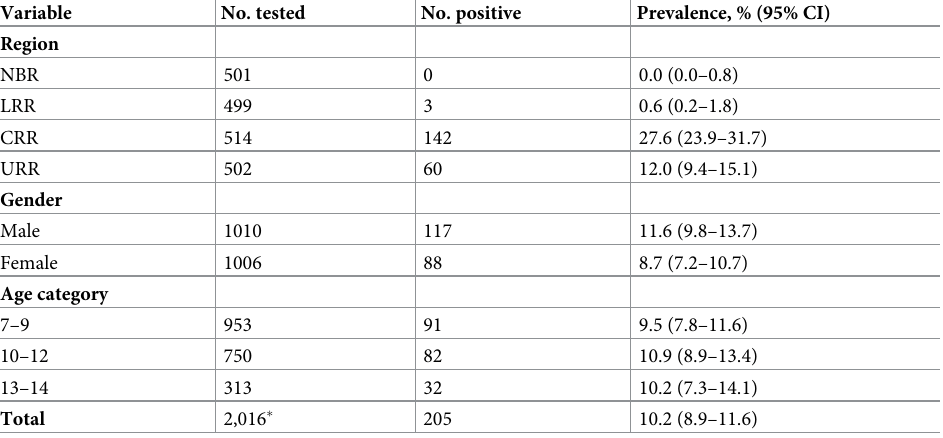
Table 1. Prevalence of urinary schistosomiasis ( S . haematobium infection) among primary school children in 4 regions of The Gambia, 2015. Variable No. tested No. positive Prevalence, % (95% CI) Region